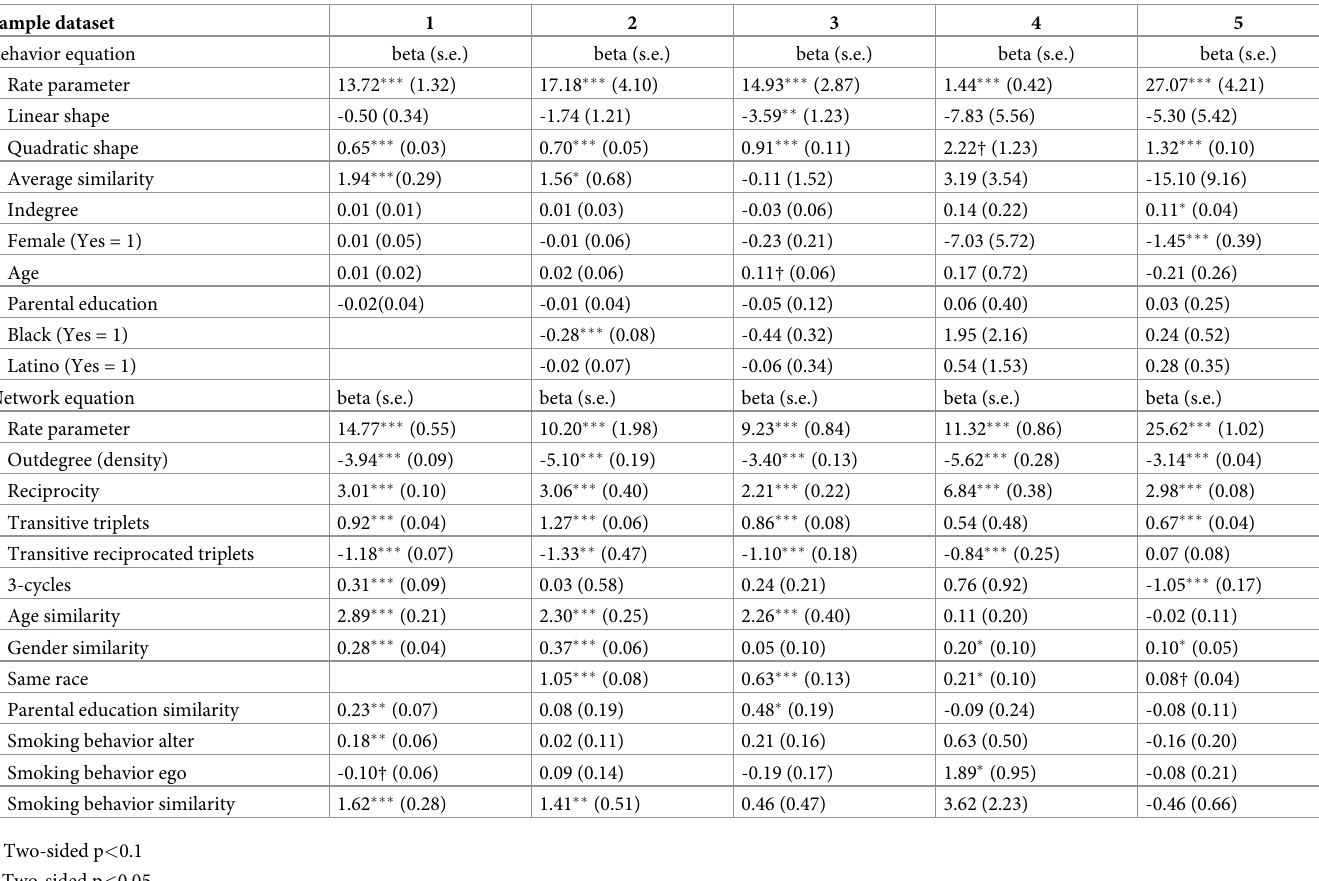
Table 3. Results from Stochastic Actor-Based